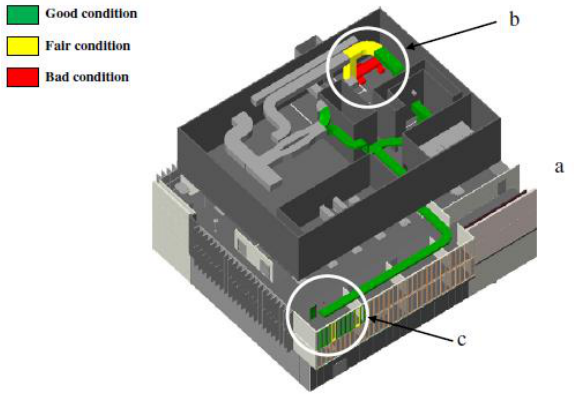
Figure 1. Visualization of FM related issues. (adopted from Motamedi et al. ,